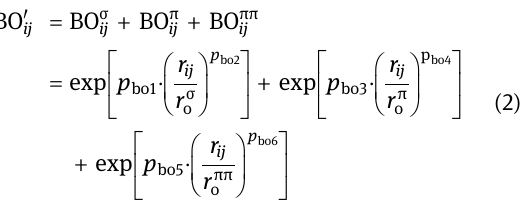
Table 2: E ff ect of reaction temperature on reaction yield Alkaline hydrolysis temperature ( °C )